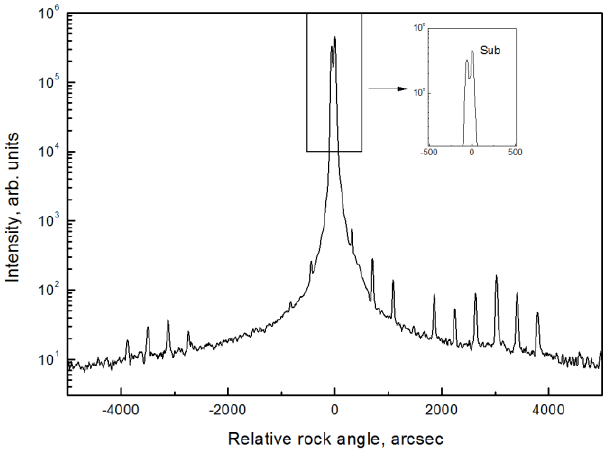
Figure 5. X-ray curve of AlGaAs/GaAs QCL heterostructure.